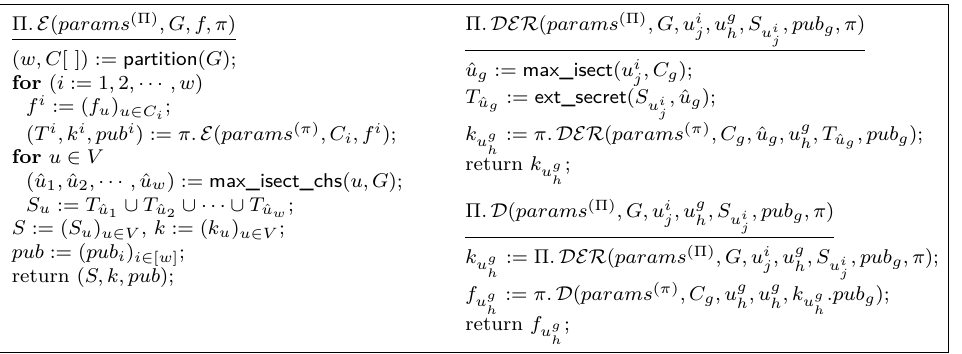
Figure 19: Algorithmic description of modified chain partition algorithm to build a KAS-AE scheme Π = (Π . E , Π . DER , Π . D ) using the KAS-AE-chain scheme π = ( π. E , π. DER , π. D